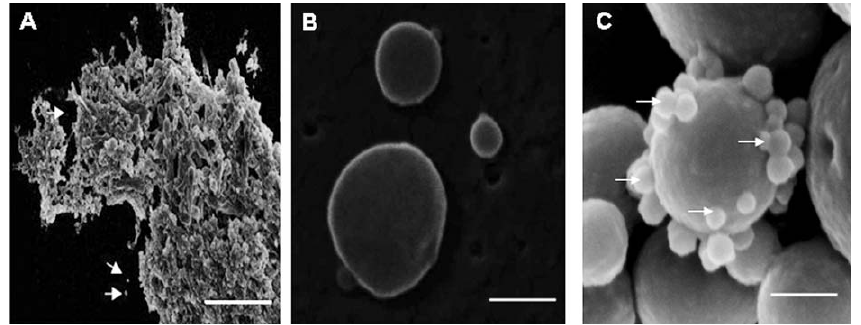
Figure 6. Detection and Purification of Vesicles from ECM (A) Scanning electron micrographs of M. ulcerans cluster showed that the ECM contains vesicles (arrows). Scale bar: 10 l m. (B) Scanning electron micrographs of vesicles purified from a culture supernatant by ultracentrifugation. The vesicle size (50 to 250 nm) is heterogeneous. Scale bar: 200 nm. (C) Scanning electron micrographs of vesicles (arrows) that were purified by immunomagnetic particle separation from an infected mouse tissue. Scale bar: 0.8 l m. doi:10.1371/journal.ppat.0030062.g006 PLoS Pathogens |